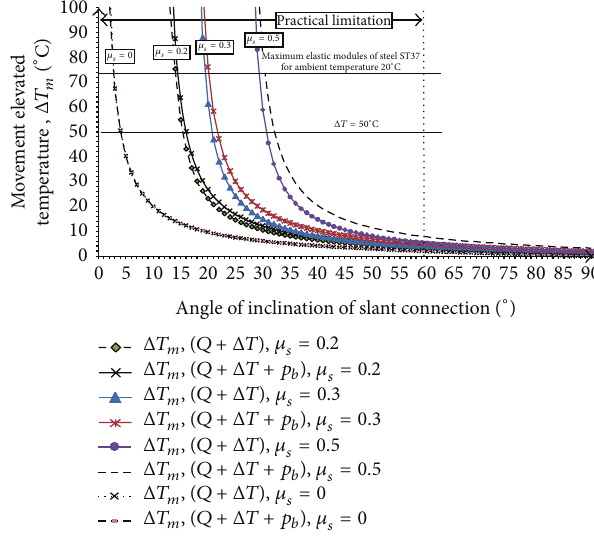
Figure 20: Relation between movement elevated temperature, Δ𝑇 𝑚 , and slope of slant connection ( 𝜃 ∘ ) due to nonsymmetric gravity